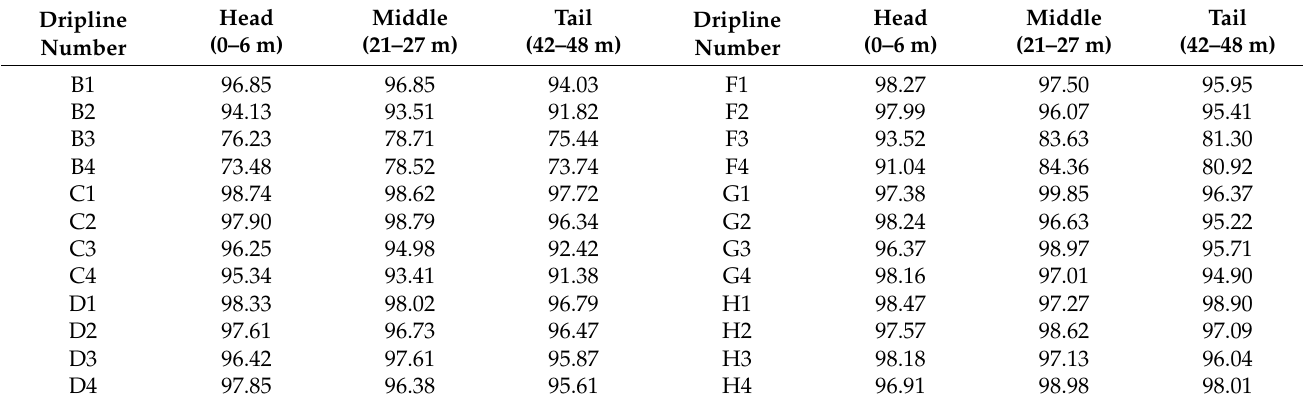
Table 4. Average relative discharges of dripline at different positions